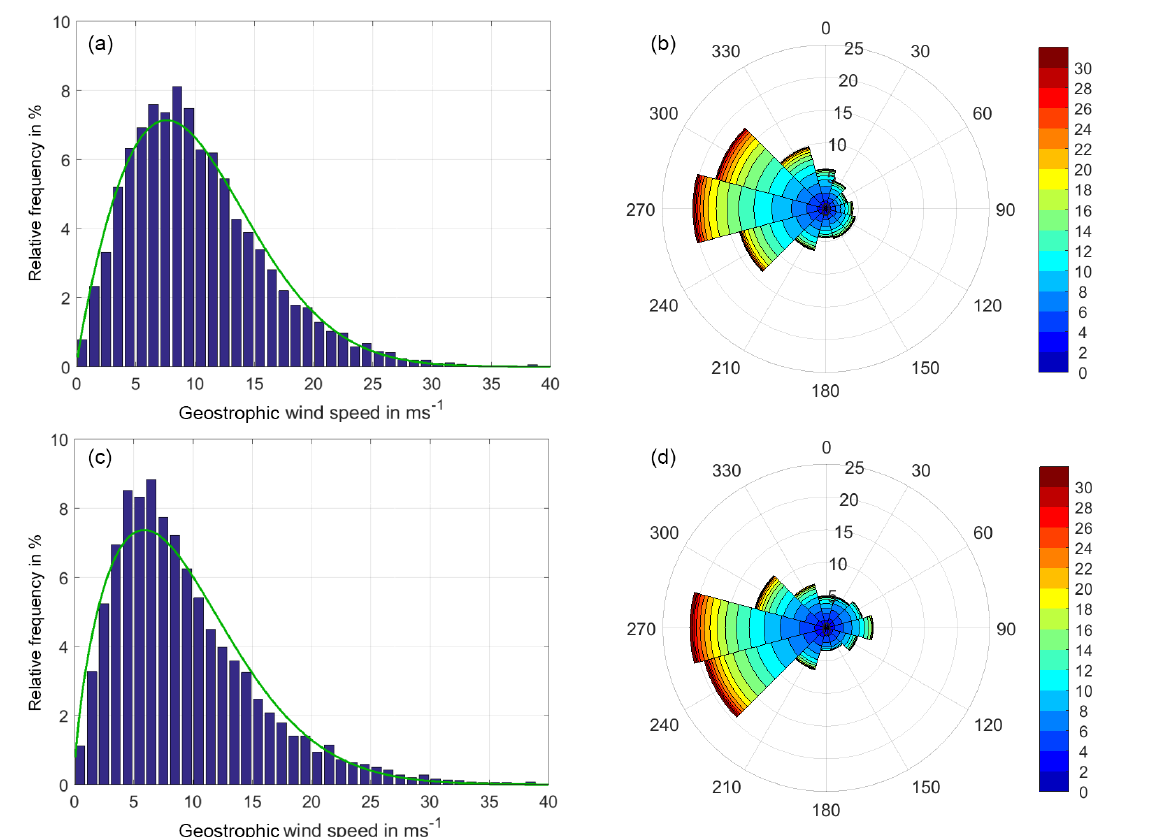
Figure 6. Wind climatology (geostrophic wind speed at 850 hPa, 00:00UTC) over 30 years (1981–2010) simulated by CCLM at two grid points: Friedland (picture above, co-ordinates: 52 ◦ 06 (cid:48) 17 (cid:48)(cid:48) N, 14 ◦ 15 (cid:48) 47 (cid:48)(cid:48) E, eastern Germany) and Philippsburg (picture below, co-ordinates: 49 ◦ 14 (cid:48) 02 (cid:48)(cid:48) N, 8 ◦ 27 (cid:48) 45 (cid:48)(cid:48) E, southwestern Germany); (a, c) : frequency distribution, (b, d) : wind rose for 12 sectors (wind direction: 0 = north, 90 = east, 180 = south, 270 = west, colors: wind speed in ms − 1 , circles: relative frequency in